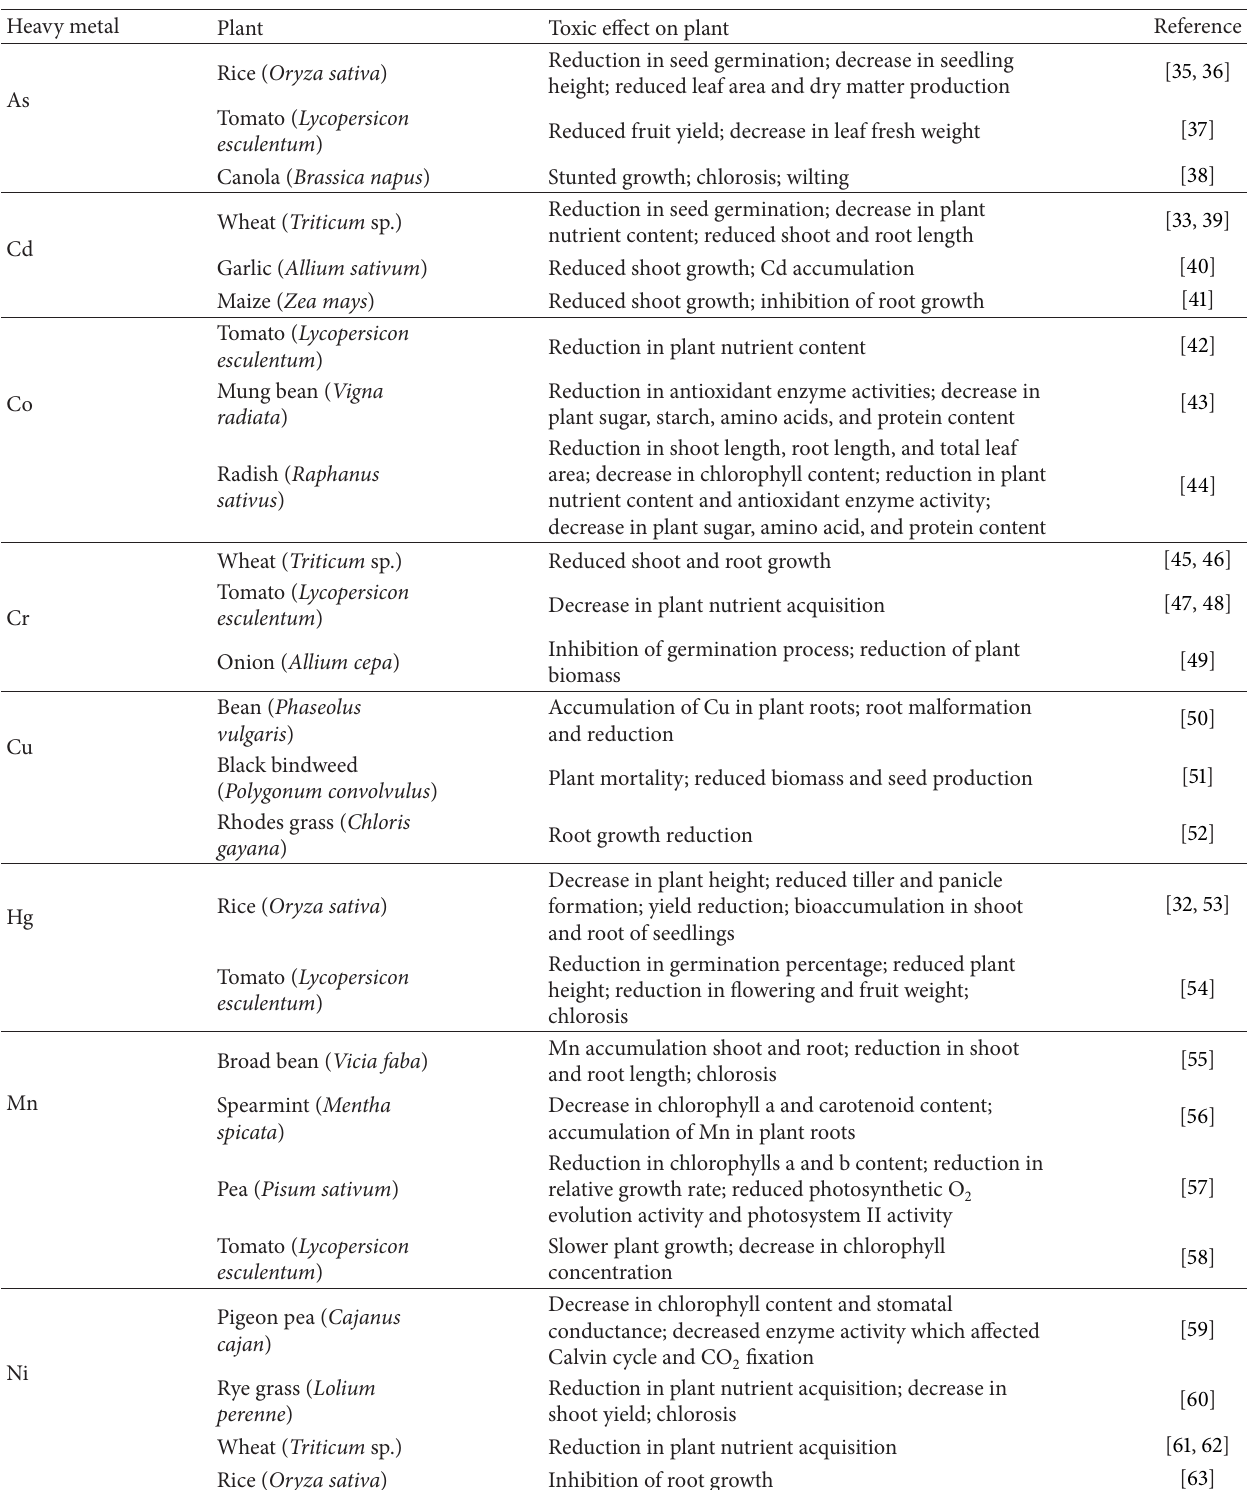
Table 1: Effect of heavy metal toxicity on